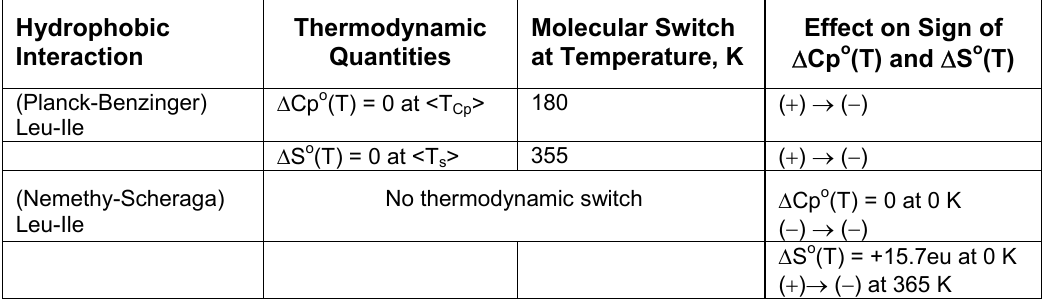
Thermodynamic Molecular Switch in ∆ Cp o (T) and ∆ S o (T)